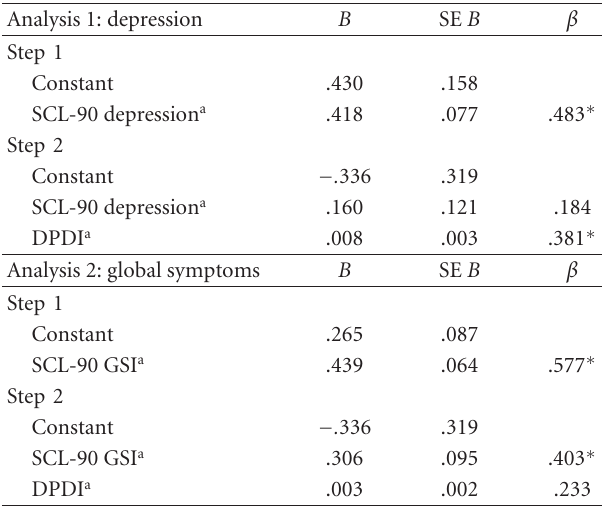
Table 3: Multiple regression analyses: DPDI as a predictor of out-